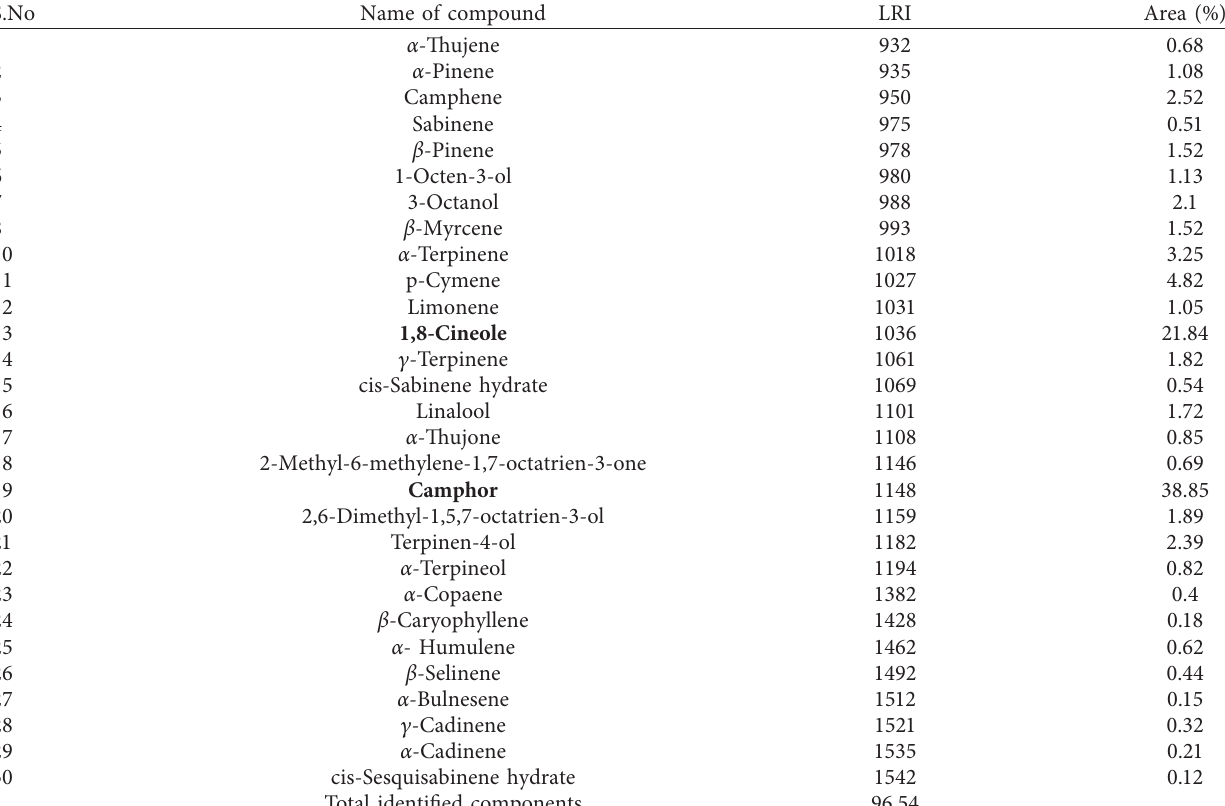
Table 1: Characterization of essential oil components of the aerial part of P. cylindraceus .